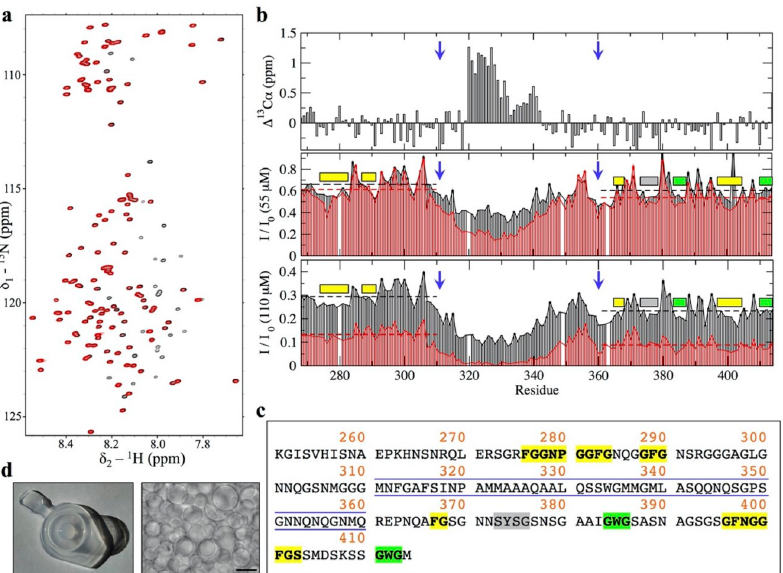
Fig 1. LSNMR characterization of the PrLD of TDP-43’s aggregation at low pH. (a) The 1 H- 15 N HSQC spectra of TDP-43 PrLD at pH 4 and 25˚C (110 μ M), showing a narrow 1 H amide chemical shift range typical of a disordered region. Black peaks correspond to a spectrum recorded within 1 hour from sample preparation, the time elapsed between column elution and the start of the NMR experiments (see Methods). The spectrum in red was the last recorded on this sample (S1 and S2 Tables), where signals corresponding to some but not all residues disappear due to self-association. (b) Signals whose intensity is lost over time correspond to the central region spanning residues 311– 360 (delimited by blue arrows), which contain an α -helix as evinced by 13 C α chemical shifts (top panel). In addition, several short segments within the 2 regions N-terminal and carboxyl terminus to the 311–360 core (i.e., 267–310 and 361–414) also exhibit moderate signal loss, which are consistently observed at 55 μ M (middle panel) and at 110 μ M (bottom panel). This is illustrated by plotting the intensity values from the first 1 H- 15 N HSQC (I 0 , black bars, 1 hour from sample preparation) and those from a 1 H- 15 N HSQC recorded approximately 20 hours later, plotted as I/I 0 (red bars, I and I 0 correspond to intensity values for the second and first 1 H- 15 N HSQC, respectively, normalized to the most intense peak). Note that average values for the 2 regions 267–310 and 361–414 N-terminal and carboxyl terminus to the central segment are shown as dashed horizontal lines (black and red colors for the I 0 and I/I 0 data sets, respectively), which highlights that the regions with lower than the average intensities mostly map to segments containing aromatic residues: Phe (yellow boxes), Tyr (gray box), and Trp (green boxes). (c) TDP-43’s PrLD sequence illustrating the central region composed of residues 311–360 (blue lines, to match blue arrows in panel b), which was the focus of some earlier studies and contains the helical segment important for assembly, as well as the aromatic residues outside this core (Phe in yellow, Tyr in gray, and Trp in green). (d) At the end of the NMR experiments, the samples were found aggregated (left panel) and displayed extensive droplet formation (right panel, scale bar: 100 μ m). This was imaged on the 110 μ M sample. The 15 N- 1 H HSQC spectra are available from Mendeley Data